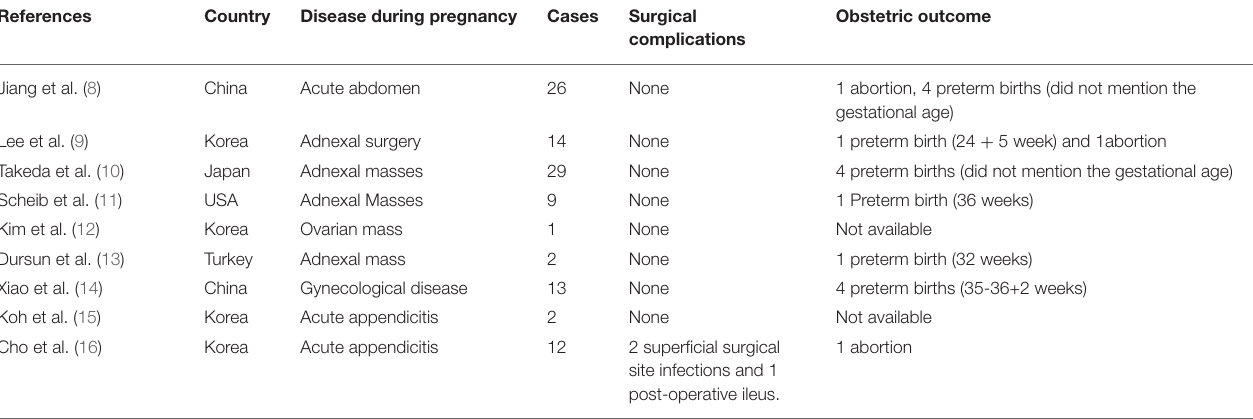
TABLE 4 | Published literature of single port laparoscopy during